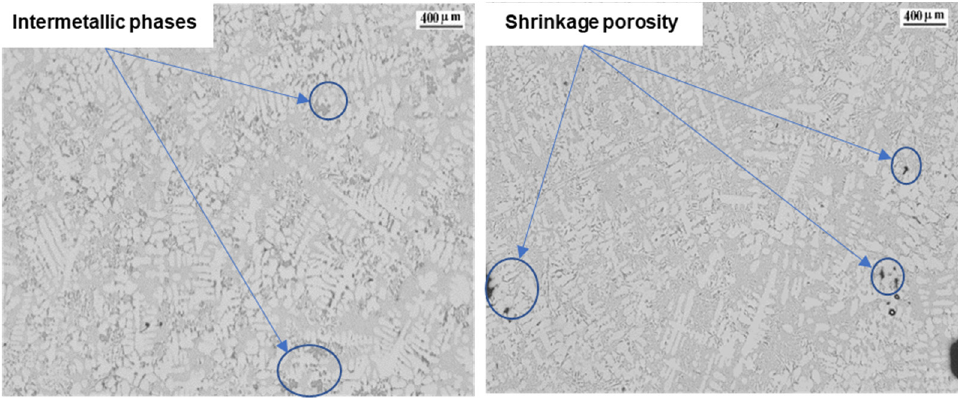
Figure 6. Microstructures of the alloy 7 and 12.